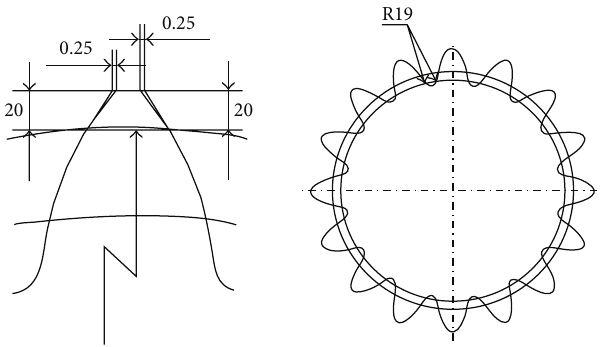
Figure 3: Design schematic diagram of the pinion.